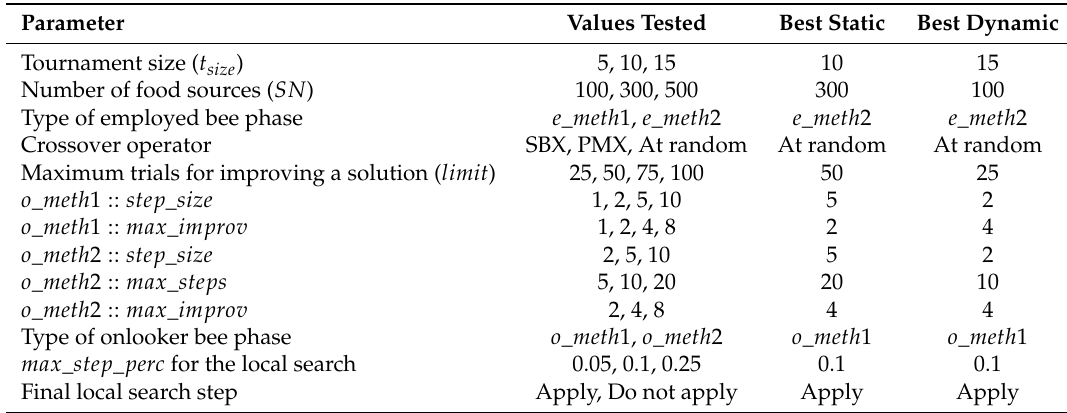
Table 1. Summary of the values tested for the parameters.